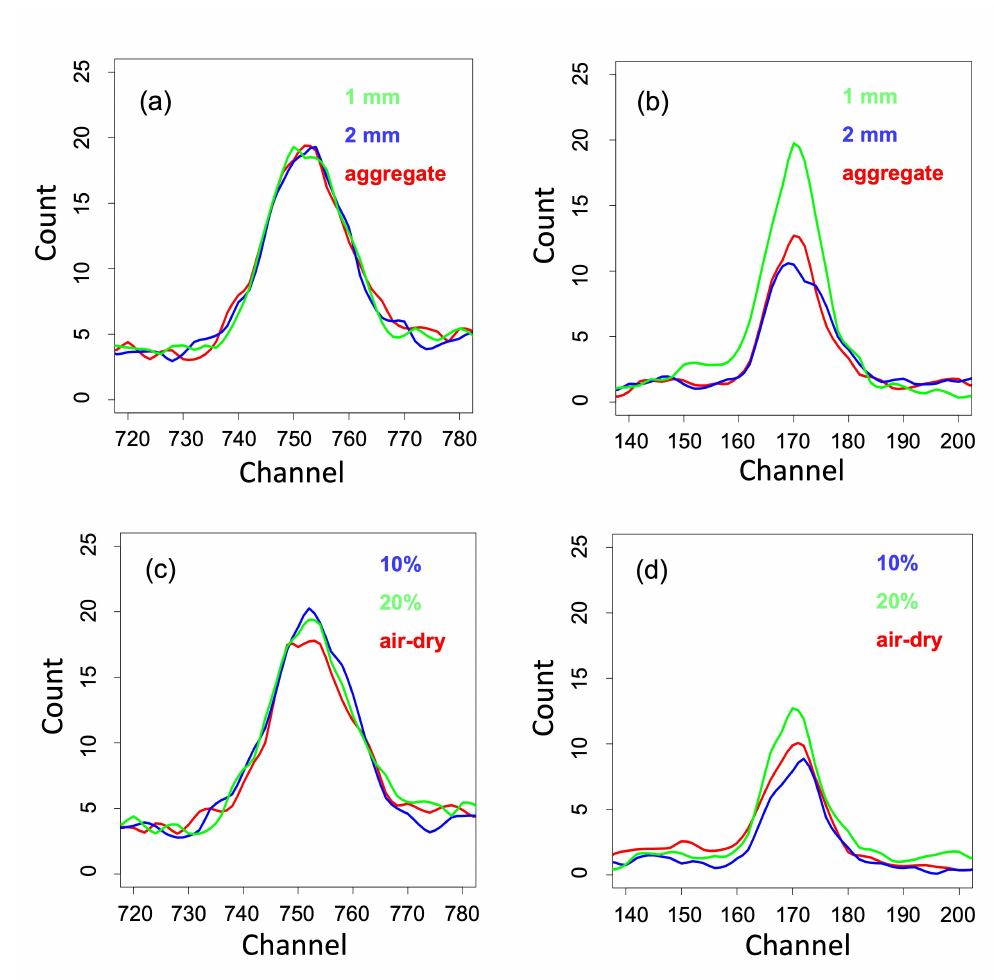
Figure 5. Difference in XRF spectral response of soil as a result of sample preparations and water content treatments for Cu ( a , c ), and Si ( b , d ). ( a , b ) are showing the effect of sample preparations while ( c , d ) are showing the effect of water